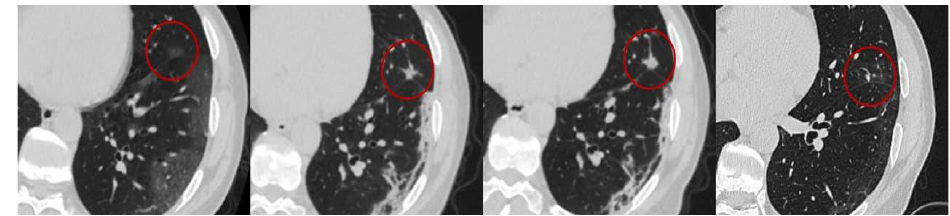
Figure 2. The red circle marks the area of ground-glass opacity, which transforms into consolida- tion (nodular pattern) area and vice versa during repetitive studies.